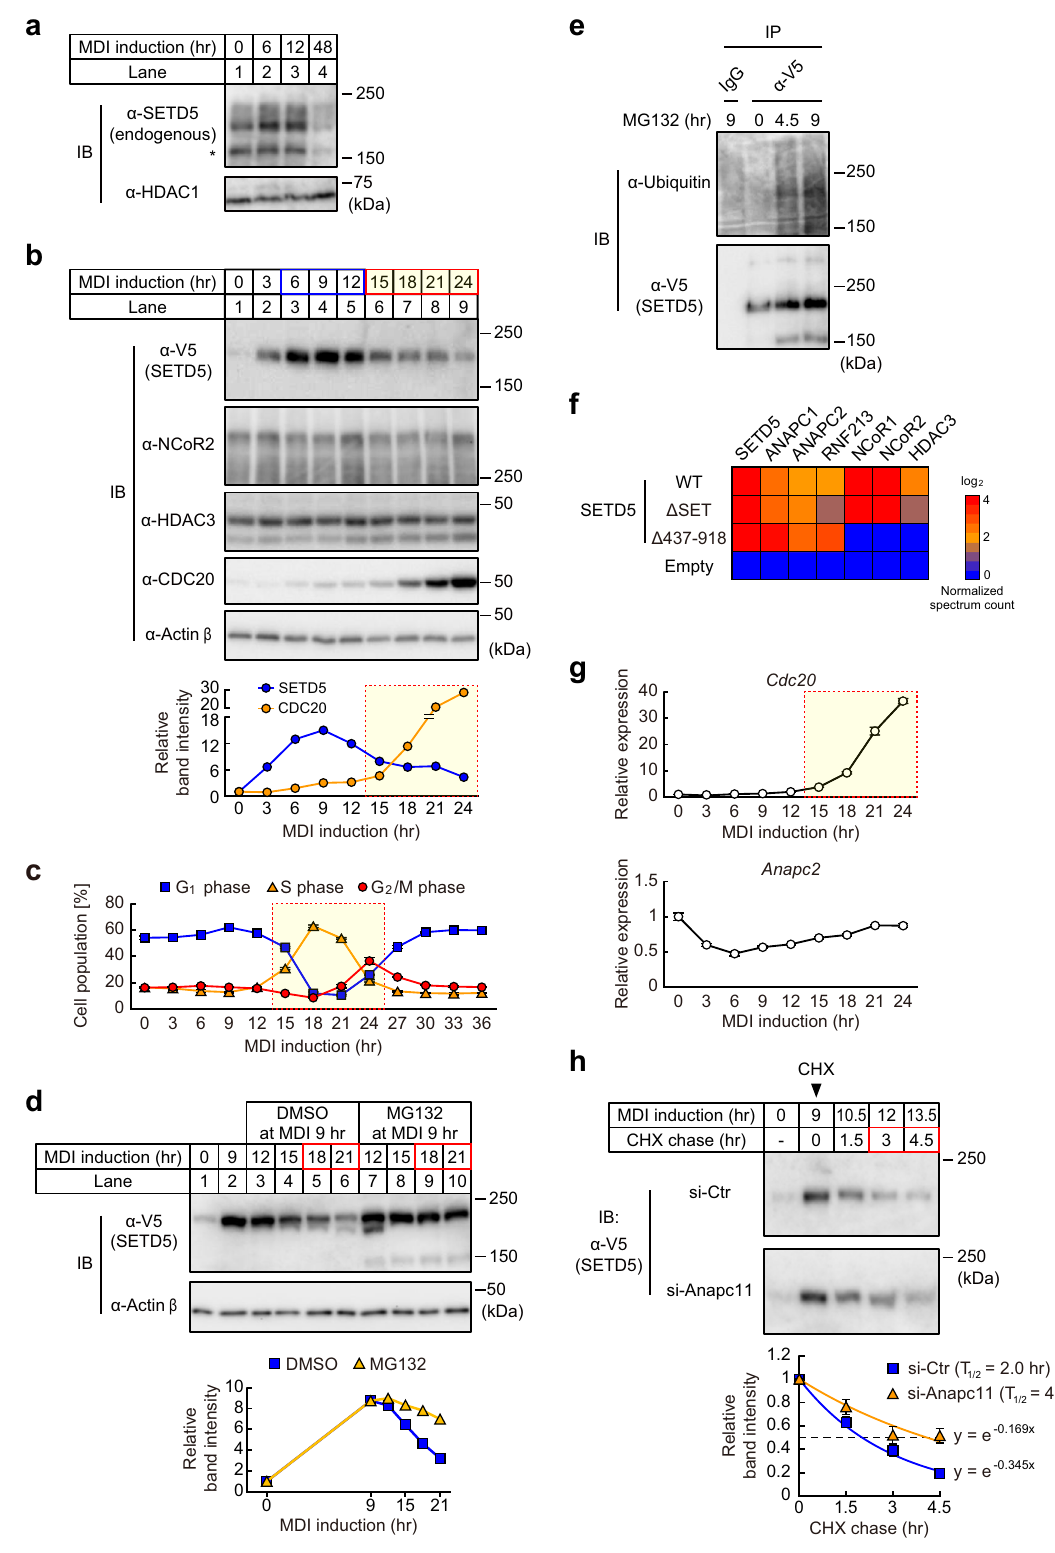
regions (Fig. 4a). When we compared the SETD5-V5 binding sites (6 h) with the H3K27ac data of 11,033 differentiation- dependent H3K27 acetylated regions at 48 h post MDI, 6,586 regions (60%) were occupied by SETD5-V5 at 6 h of differentia- tion (Fig. 4b, left Venn diagram). SETD5 bound and unbound regions were further classi fi ed into three groups each based on